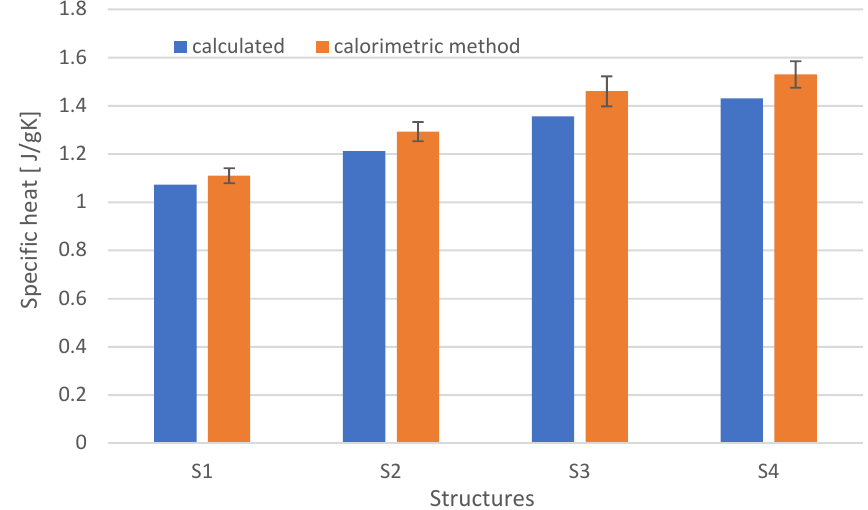
Figure 6. Specific heat for different composite structures.